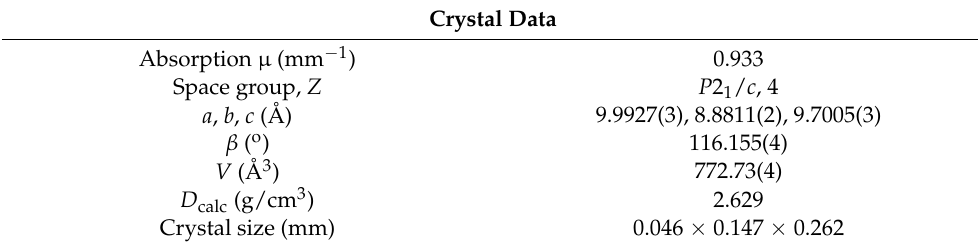
Table 1. Na 2 Al 2 O(PO 4 ) 2 · 0.12H 2 O: crystal data and details of X-ray diffraction and structure